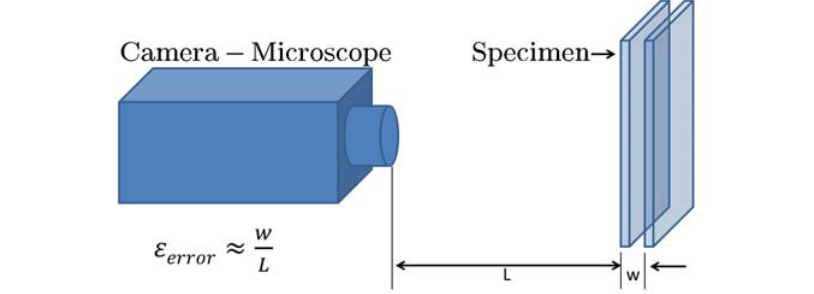
Figure 2: Error resulting from changes in the camera–specimen distance.